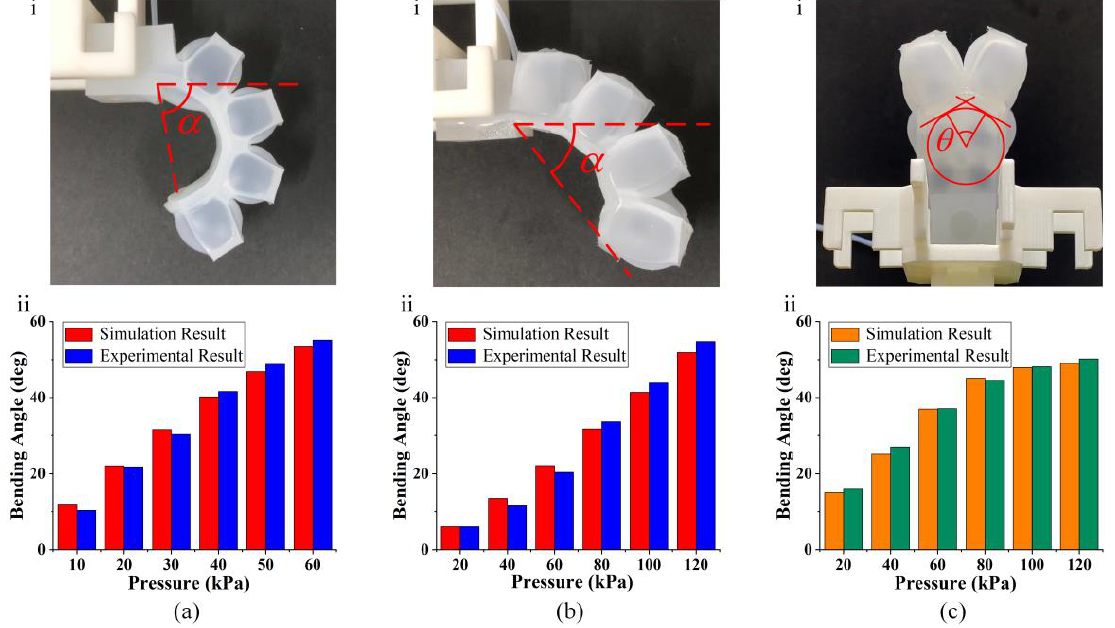
Figure 4. Bending performances of the regular and herringbone actuators. 𝛼 and 𝜃 present the Figure 4. ( a ) Bending behavior of the regular actuator ( i ), and the bending angle comparisons ( ii ). longitudinal and transverse bending angles, respectively. ( a ) Bending behavior of the regular actu- ( b ) Longitudinal bending behavior of the herringbone actuator ( i ), and the longitudinal bending ator ( i ), and the bending angle comparisons. ( b ) Longitudinal bending behavior of the herringbone angle comparisons ( ii ). ( c ) Transverse bending behavior of the herringbone actuator ( i ), and the actuator ( i ), and the longitudinal bending angle comparisons. ( c ) Transverse bending behavior of transverse bending angle comparisons ( ii ). the herringbone actuator ( i ), and the transverse bending angle comparisons.